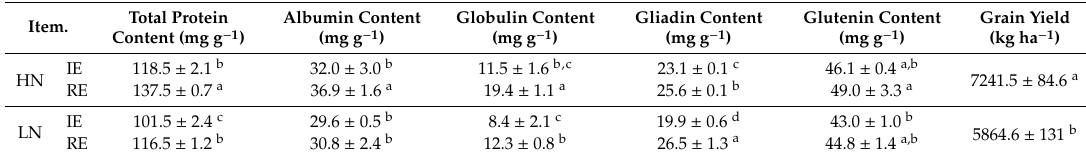
Table 1. Protein content of the innermost endosperm (IE) region and the remaining endosperm (RE) region from plants grown in high nitrogen (HN) and low nitrogen (LN) treatments.